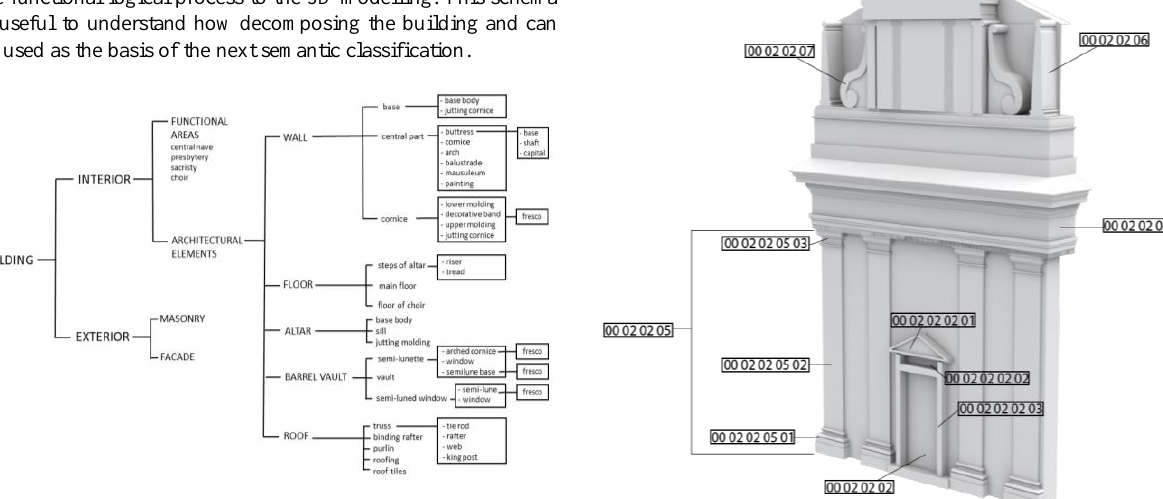
Figure 10. Graph of the geometrical classification and the architectural elements